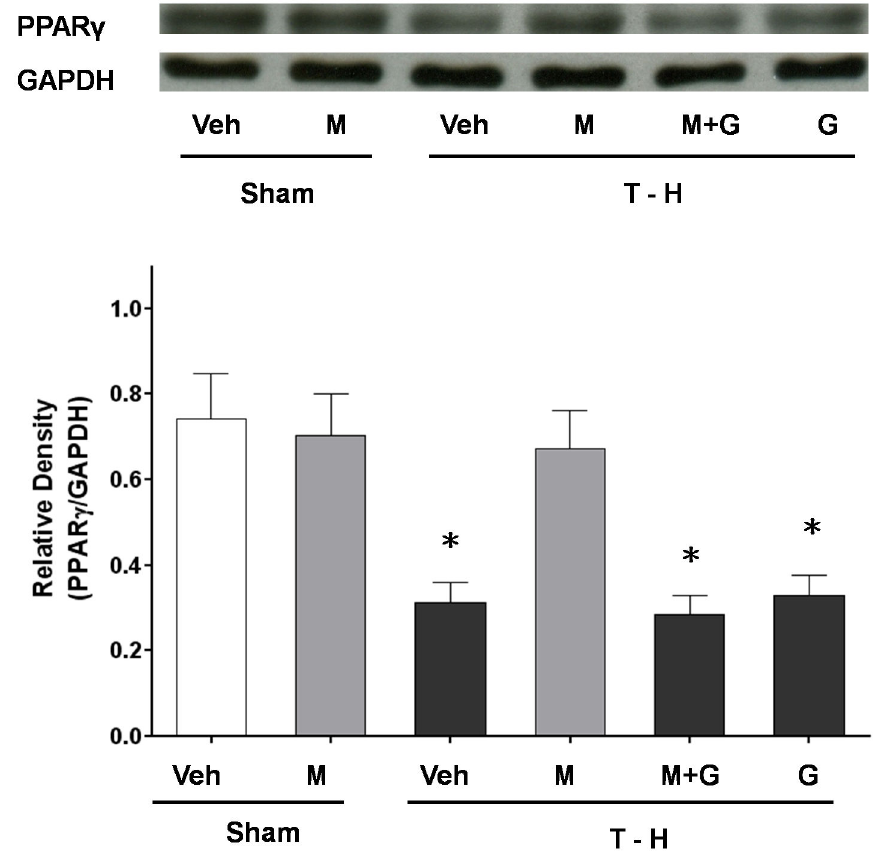
Figure 6. Hepatic PPAR protein expressions from sham-operated animals receiving vehicle (Sham+Veh; lane 1) or γ maraviroc (Sham+MA; lane 2), trauma-hemorrhage animals receiving vehicle (T-H+Veh; lane 3), maraviroc (T-H+MA; lane 4), maraviroc and GW9662 (T-H+MA+G; lane 5) or GW9662 (T-H+G; lane 6). Blots were reprobed for GAPDH as a control for equal protein loading in all lanes. The bands were analyzed using densitometry, and the values are presented as mean ± SEM for 8 rats in each group. * p <0.05 versus all other